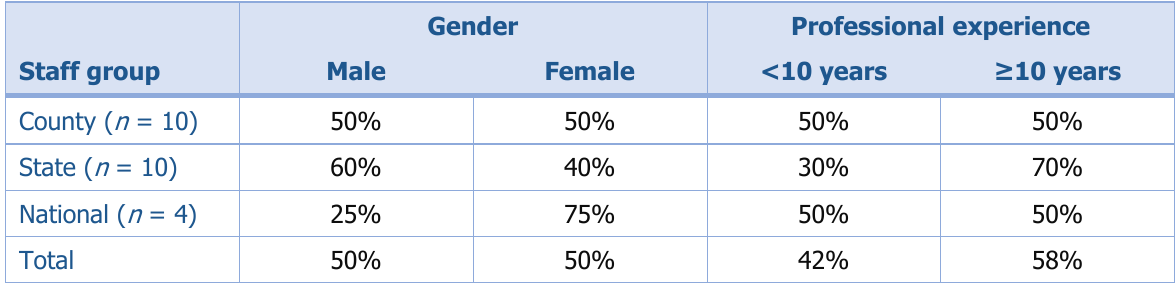
Table 1. Interview Participants by Role, Gender, and Years of Experience in